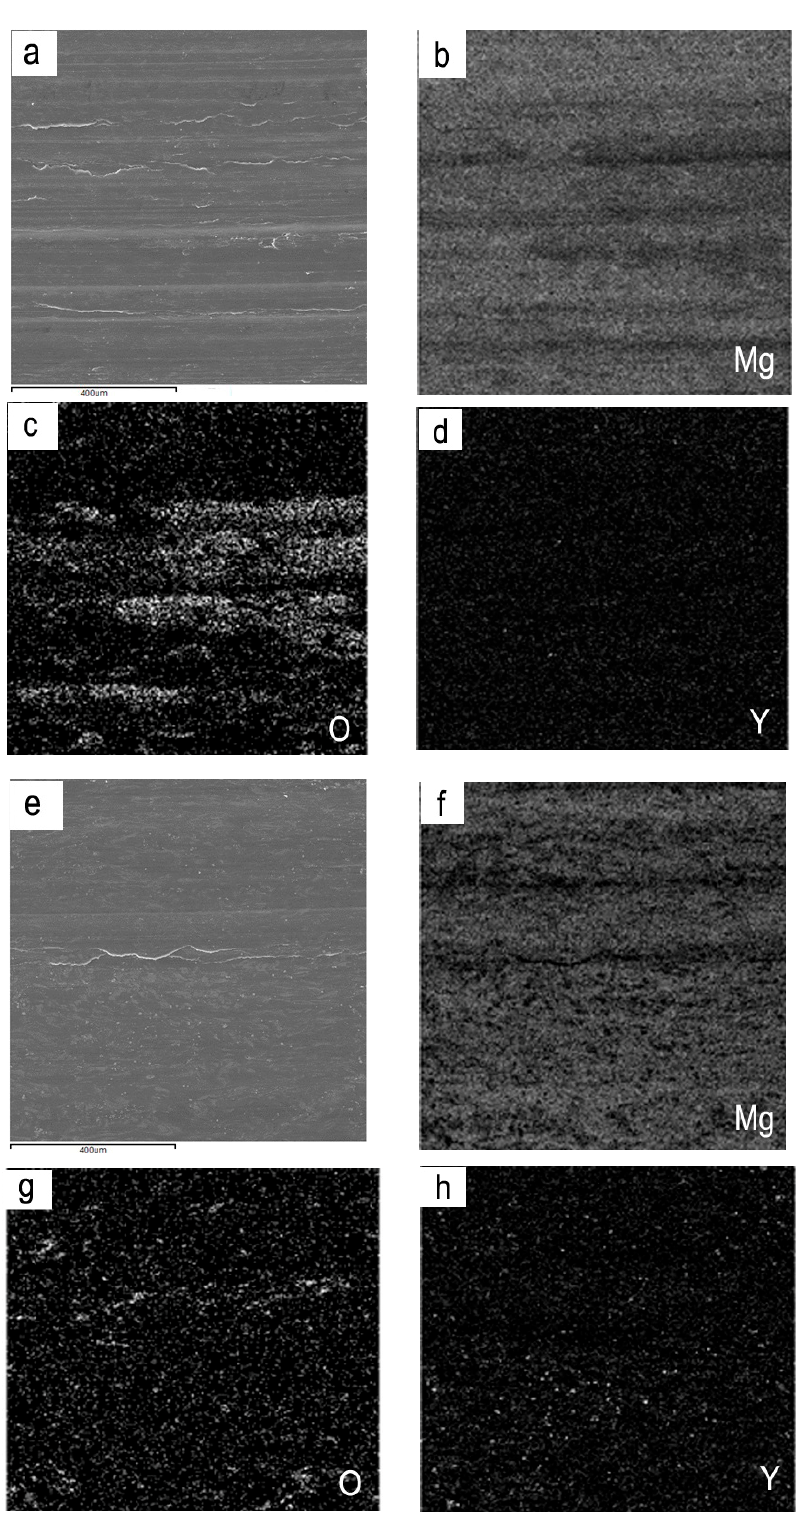
Figure 3. SEM images and EDS mapping of worn surfaces at different applied loads and test temperature under 0.8 m/s: ( a ) SEM image at 120 N, 150 °C, ( b ) O, ( c ), Mg, ( d ) Y, ( e ) SEM image at 80 N, 200 °C, ( f ) O, ( g ) Mg, ( h ) Y.